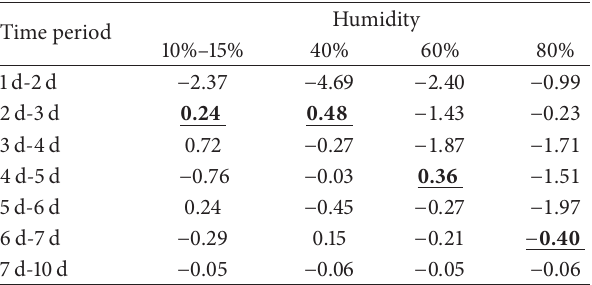
Table 7: Water content variation rate (water content variation rate,